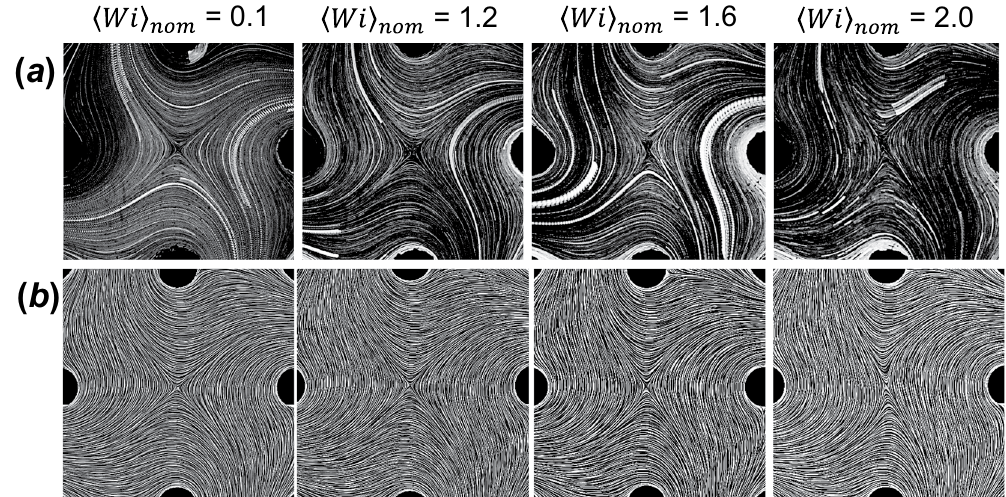
Figure 7. Streakline and streamline images of flows in the FFoRM geometry for ( a ) PTV experiments with an elastic Boger fluid and ( b ) CFD simulations of an Oldroyd-B fluid. Device operation conditions are for nominally extensional flows ( Q 1 / Q 2 = 1) with nominal center plane deformation rates, Wi nom , indicated above